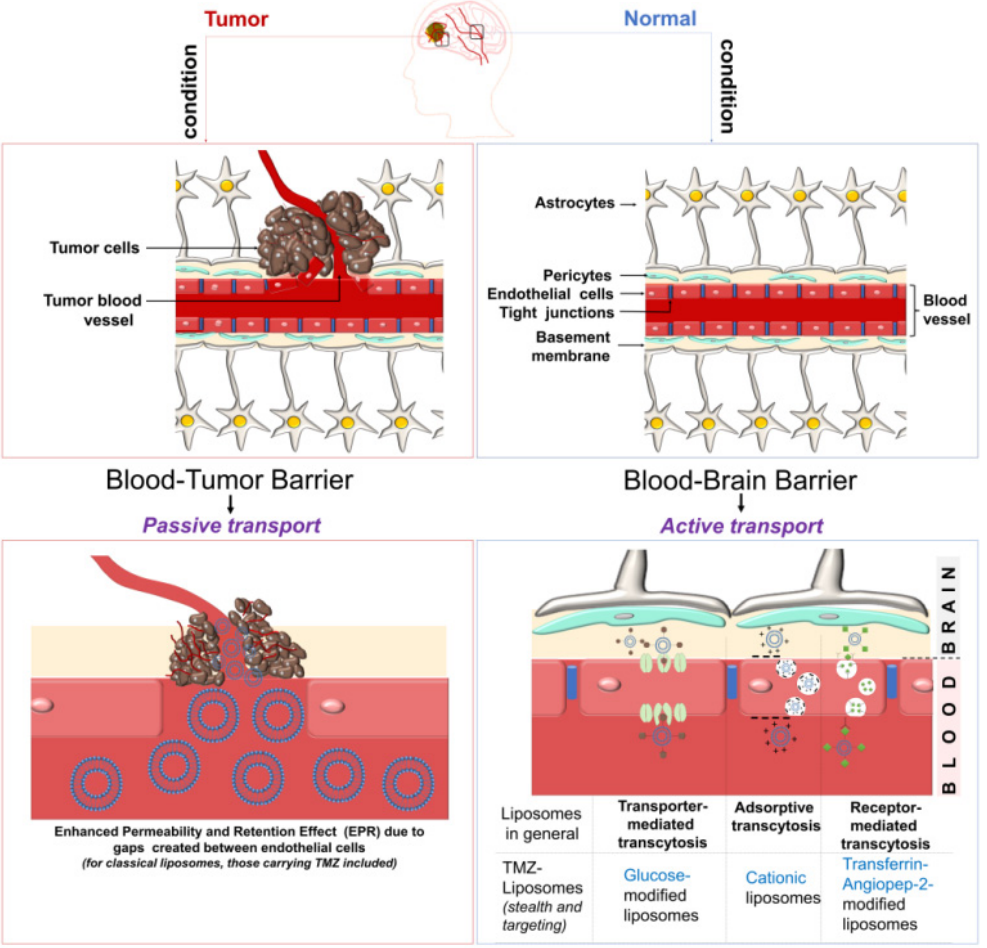
Figure 5. Strategies for TMZ-liposomes crossing the BBB and BTB.